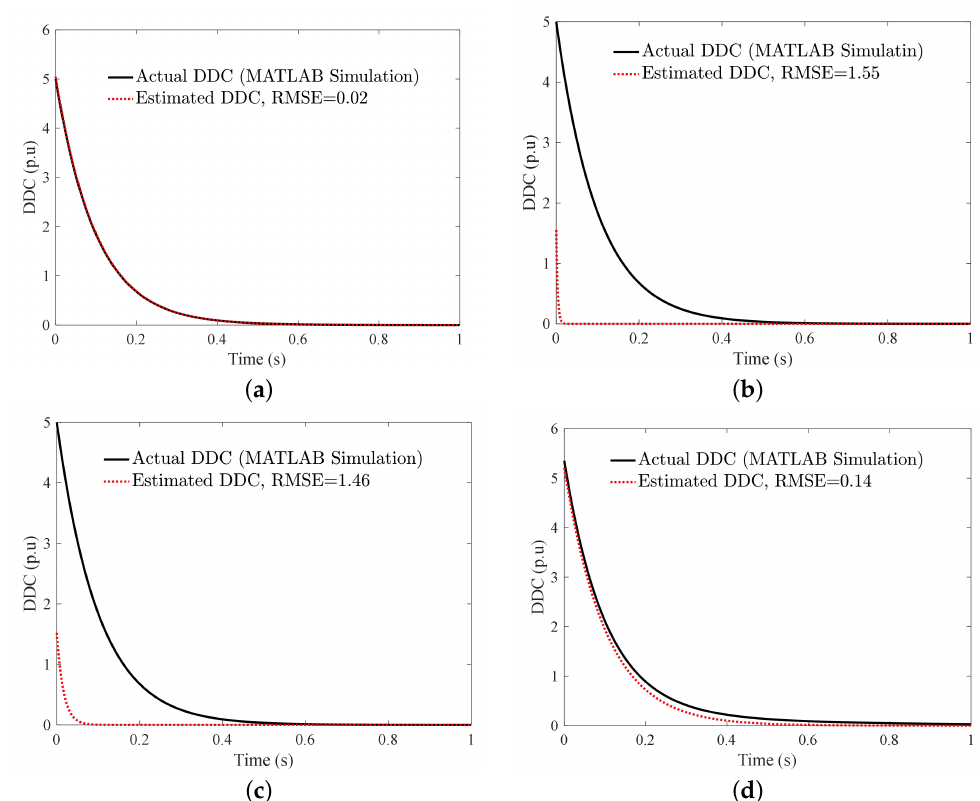
Figure 13. simulation results, method [22] (red line), under four different cases: ( a ) without noise, ( b ) in the presence of noise, ( c ) 0.5 Hz frequency deviation, ( d ) in the presence of the second DDC. A modified half/FCDFT method based on the adaptive mimic filter is presented in